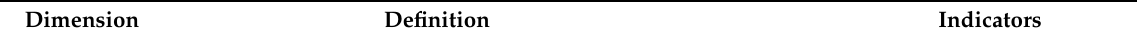
Table 3. Comfort, aesthetics, and safety indicators measured in